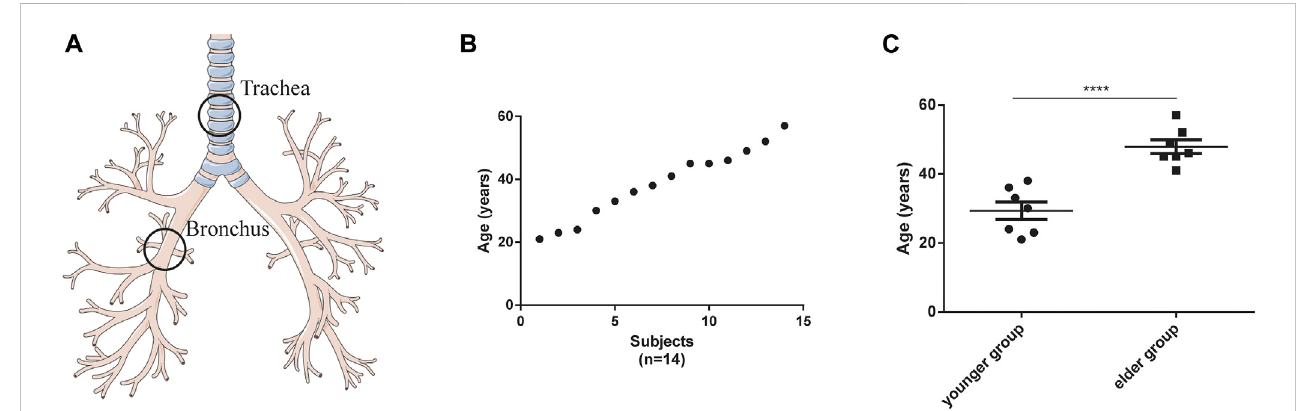
FIGURE 1 Characteristics of tracheal and bronchial brushings. (A) Schematic of brushing sample collection. (B) age distribution of the participants ( n = 14). (C) Age difference between the younger ( n = 7) and elder ( n = 7) groups. **** p <